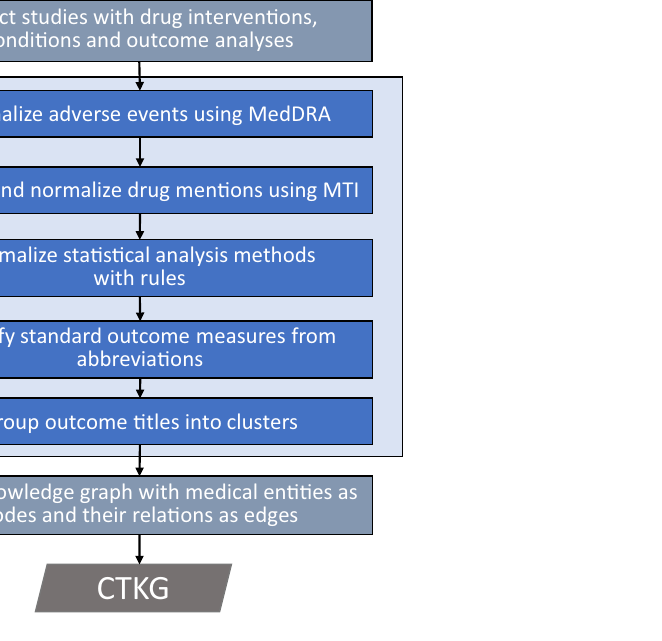
Figure 2. Flow chart of CTKG